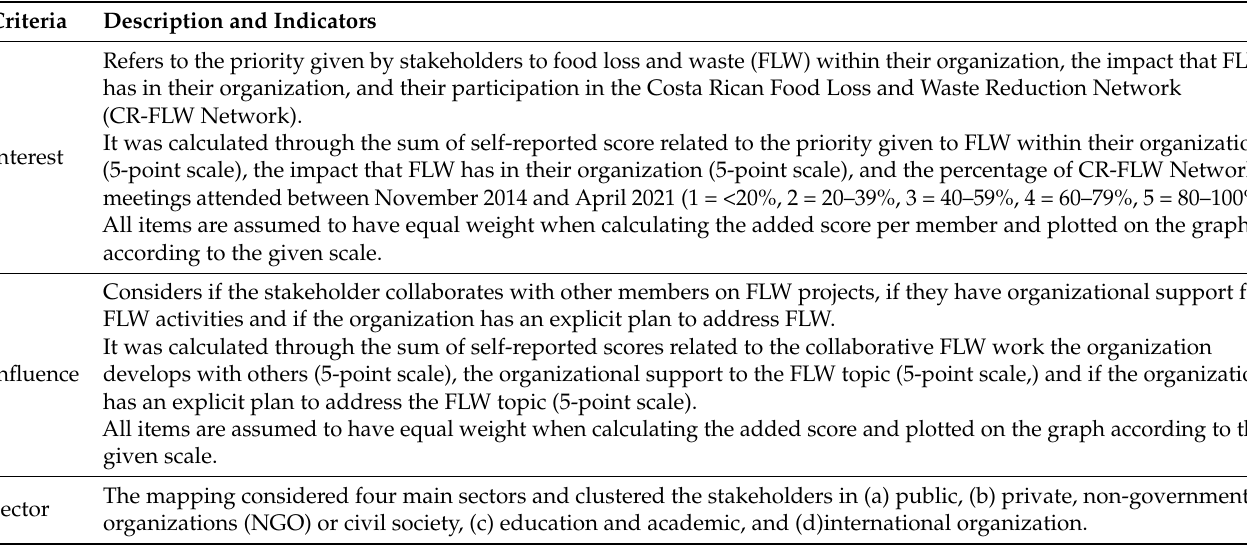
Table 1. Criteria and indicators used to conduct the stakeholder